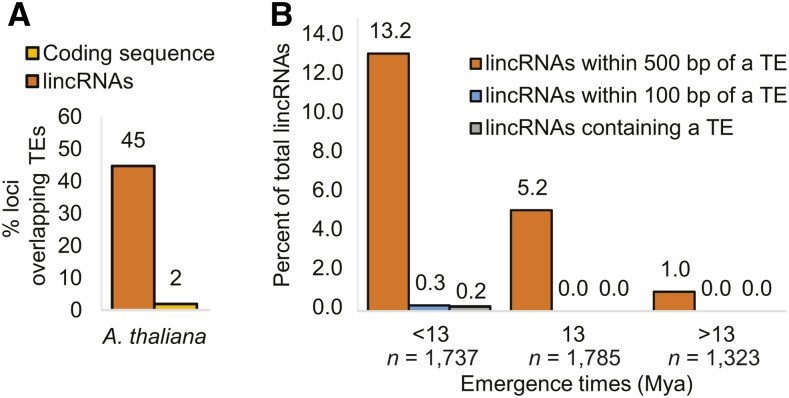
Transposable element (TE) content in AtlincRNAs. (A) Percent of lincRNAs and coding sequences from A. thaliana that overlap with ≥ 10 bp of a TE as determined by RepeatMasker. Actual percent shown above each bar. (B) Connection between TEs and AtlincRNA emergence. AtlincRNAs were binned based on when they are believed to have emerged [shown on x-axis in millions of years ago (Mya)]. TE content, either within or adjacent to the lincRNA, was determined for AtlincRNAs within each bin.